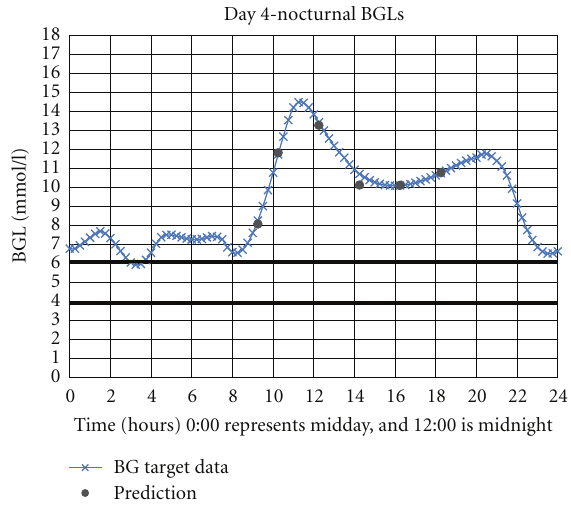
Figure 11: Predictions from trained ANNs on a test day which was not used during AIDA training. Each point represents a separate ANN, which was the best performing ANN over the 5 test days for a given prediction period.